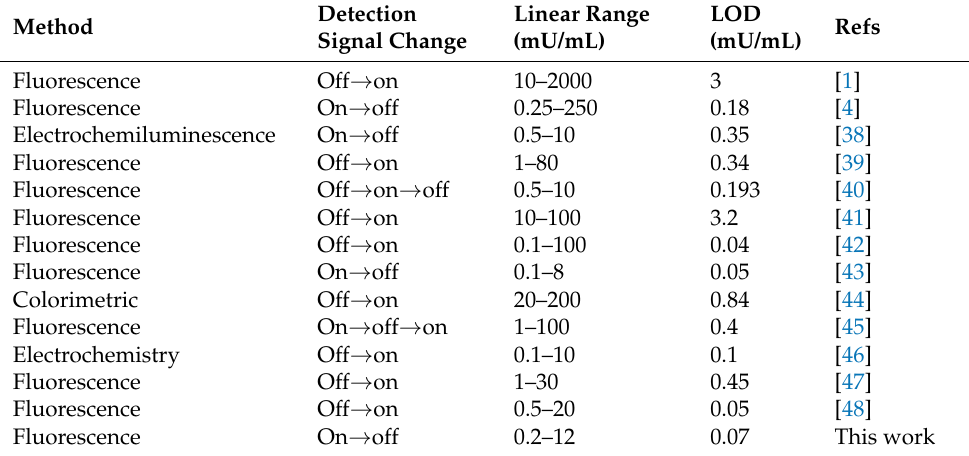
Table 1. A comparison of the different methods used for the detection of ALP activity.